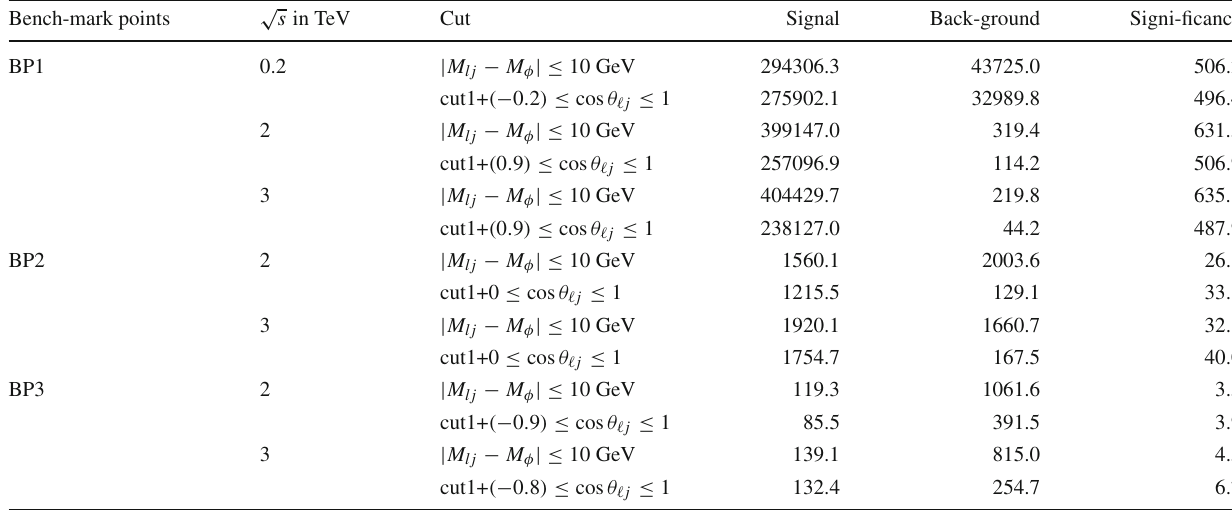
/ 3 ) c with luminosity 100 fb − 1 at e – γ collider 2 μ